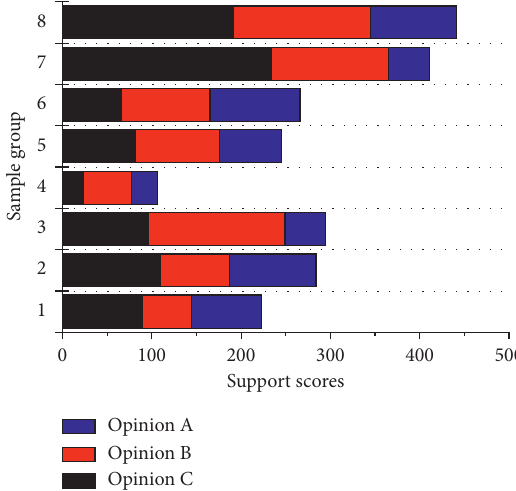
Figure 5: Distribution of public policy and public opinion